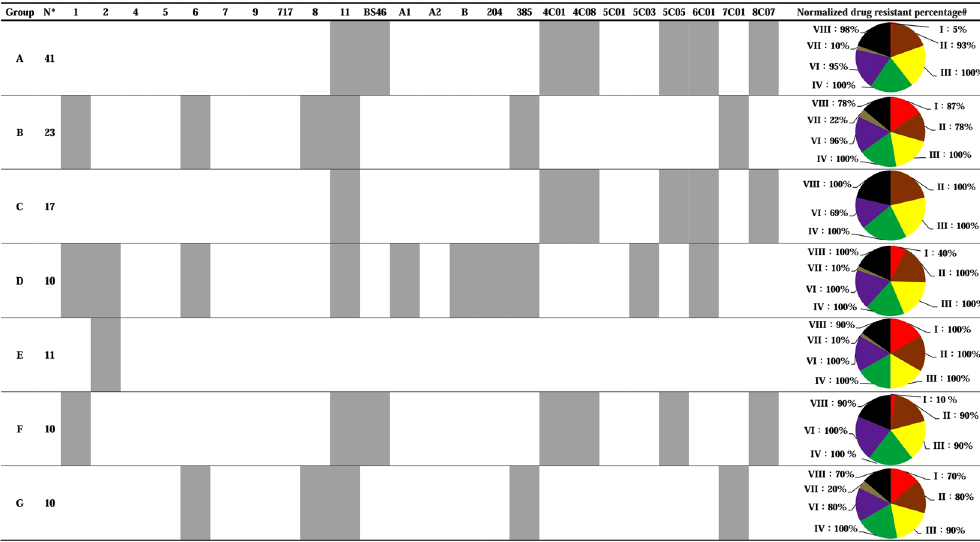
Figure 2. Phage infection profiles that contained at least 10 samples of clinically isolated A. baumannii (total N = 122), and the normalized drug resistance percentages to the eight groups of antibiotics. The different colors in the pie charts represent the different groups of antibiotics: Group